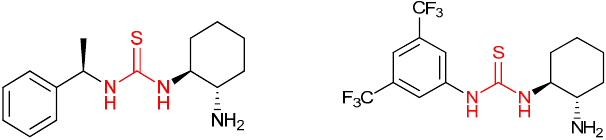
Figure 9. DACH-based thioureas bearing primary amine function [164–171].